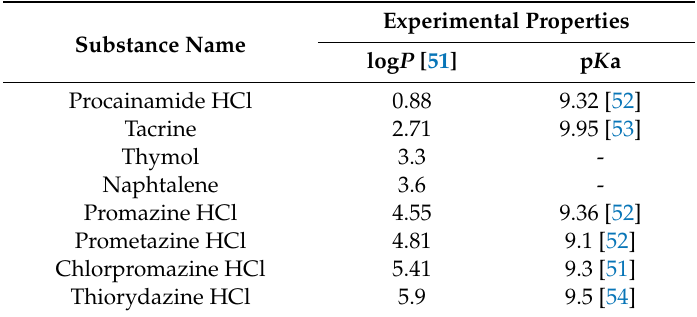
Table 5. Substances used to prepare the calibration